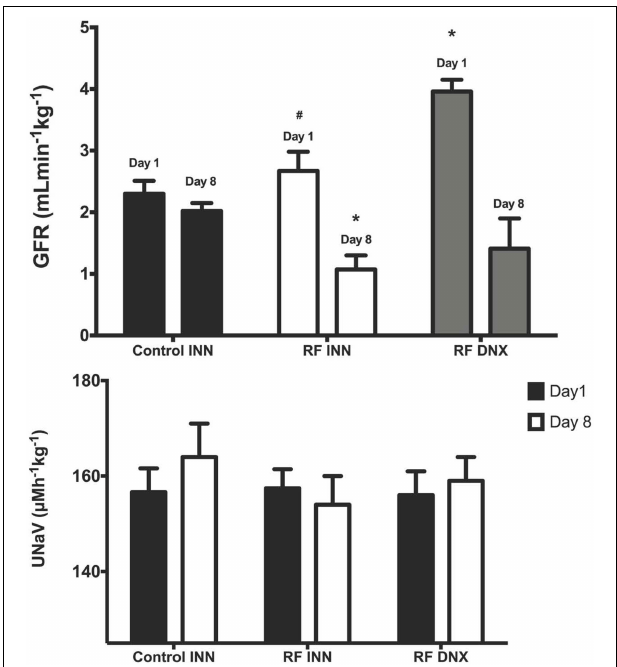
FIGURE 2 | Creatinine clearance (glomerular filtration rate, GFR), upper graph (A) and sodium excretion (Lower graph, B) for innervated (INN) control, renal failure (RF INN) and renally denervated RF (RF DNX) rats on day 1 and 8 of the metabolic study. Statistical analysis was performed using Two-Way ANOVA followed by Tukey’s post-hoc test. Data presented as mean SEM. ( n = 12 for all groups). * P < 0 . 05 vs. Control INN; # P < 0 . 05 vs. RF DNX. P -value for interaction < 0.005.